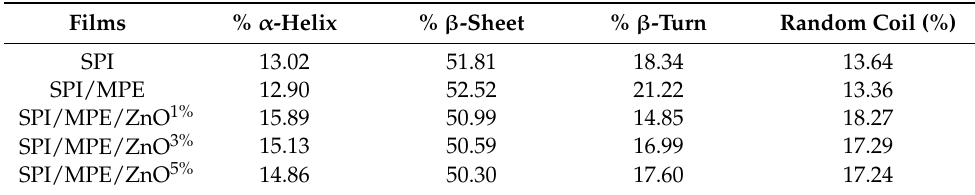
Table 3. Secondary structure contents of the